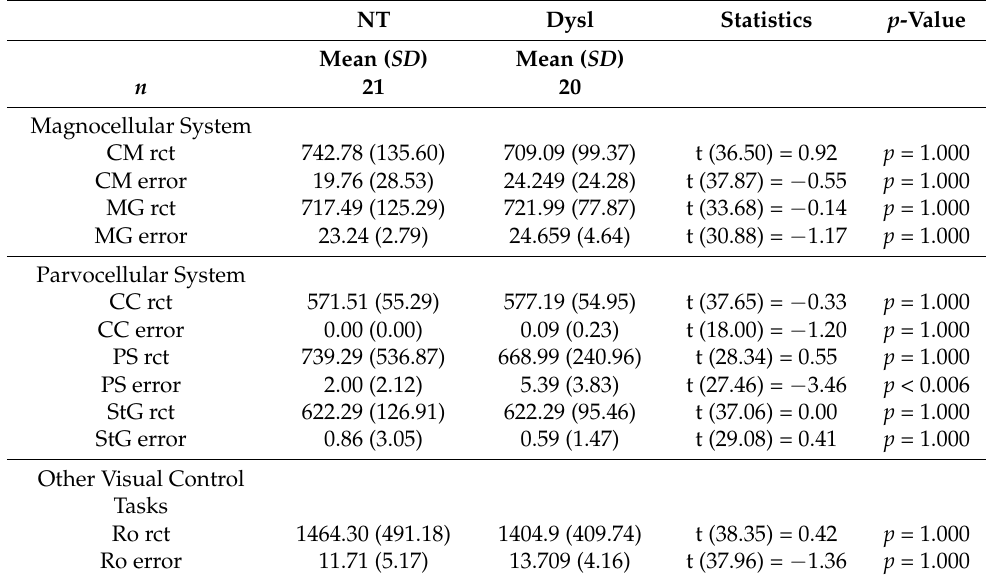
Table 6. Visual performance.